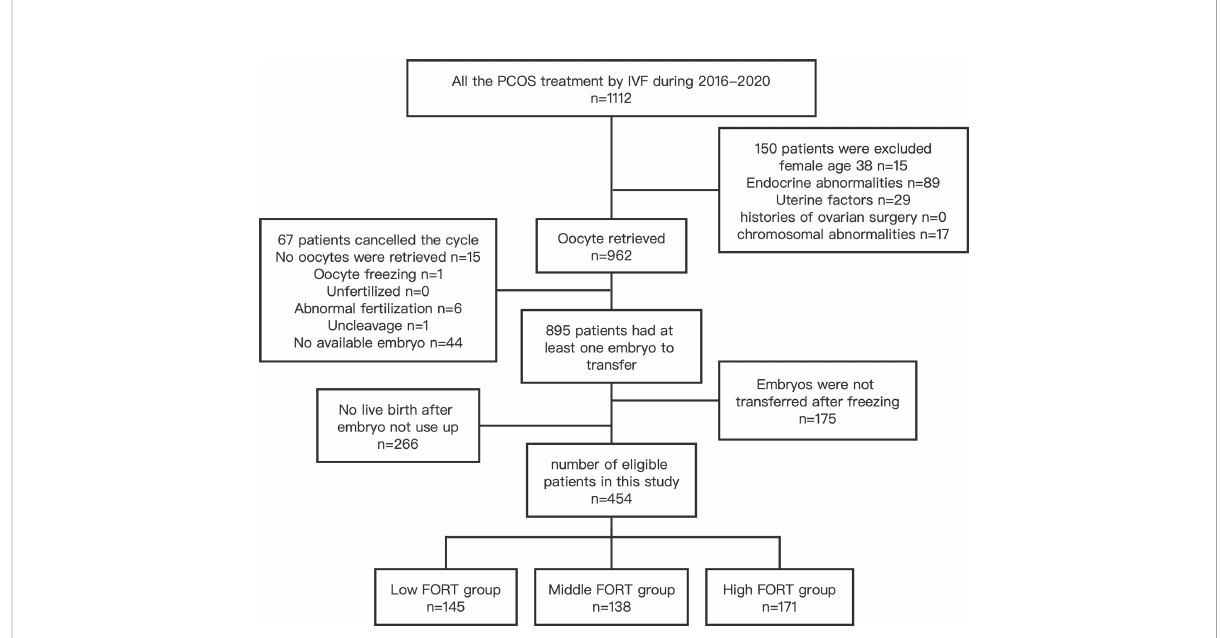
FIGURE 1 Flow chart for selection of patients from January 2016 to December